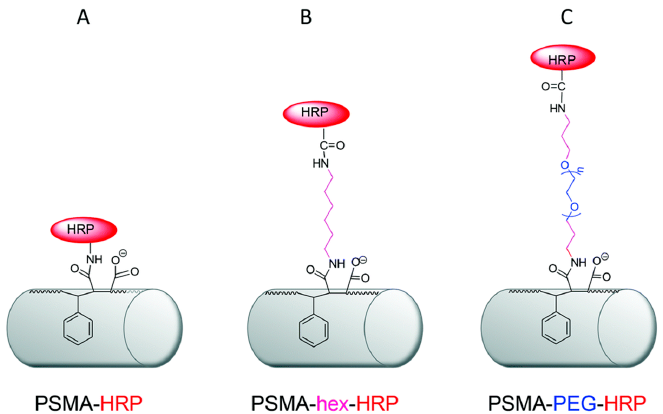
Figure 15. Schematic view of the di ff erent HRP functionalized fibers: PSMA-HRP ( A ), PSMA-hex-HRP ( B ), and PSMA-PEG-HRP ( C ). Reproduced with permission from [168]. Copyright Royal Society of Chemistry.